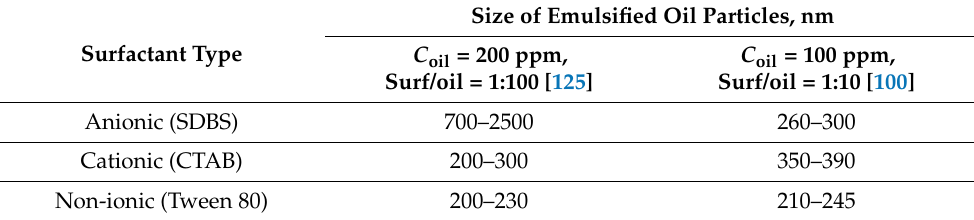
Table 9. Effect of surfactant type on the size of emulsified oil